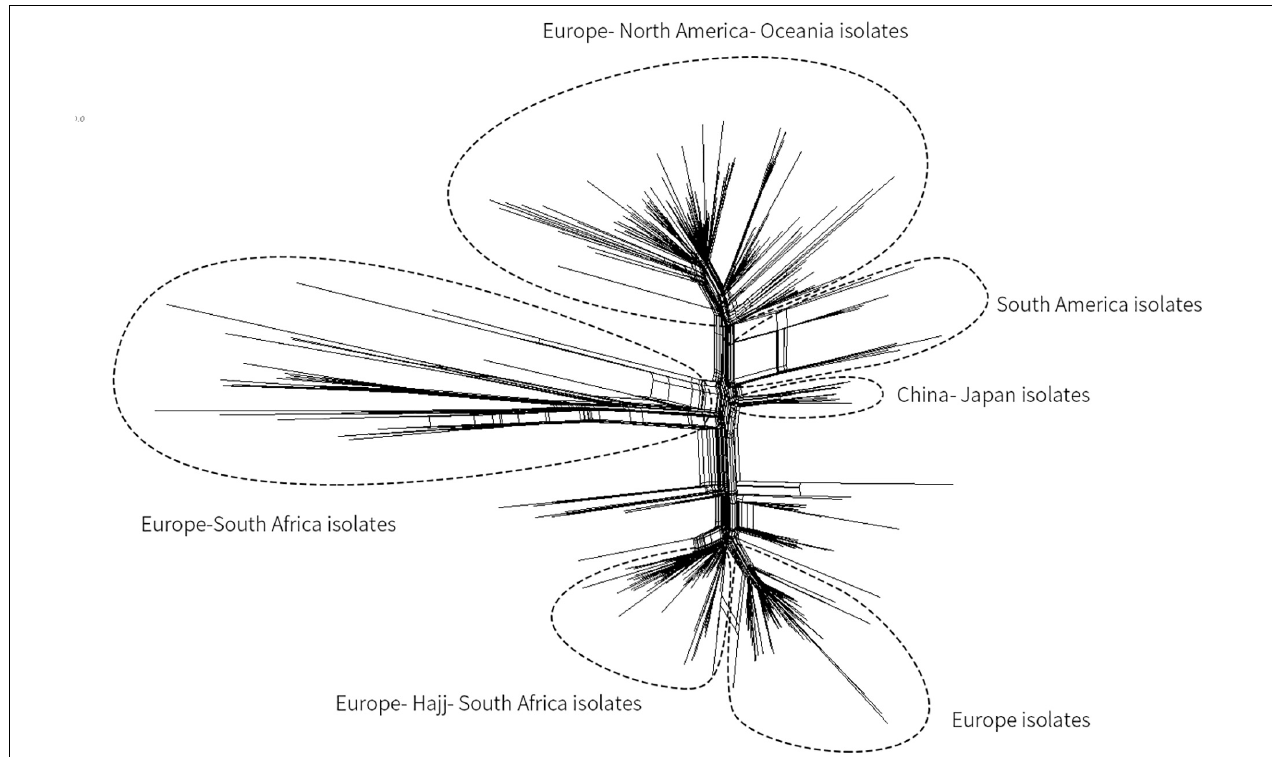
FIGURE 3 | Core genome multilocus sequence typing (MLST) neighbor-net phylogenetic tree for the distribution of MenW CC ST-11 isolates from China and additional international isolates. The tree was constructed with SplitsTree4 version 4.13.1 (http://www.splitstree.org).